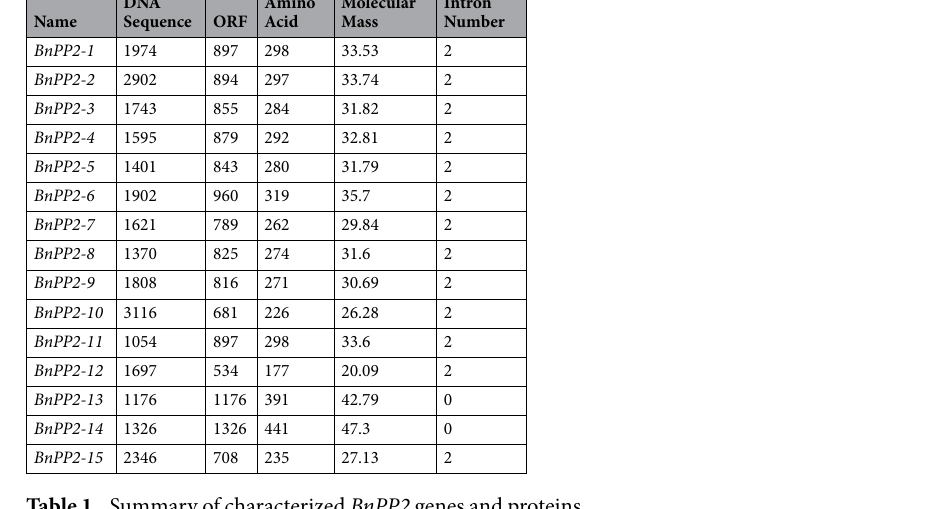
Table 1. Summary of characterized BnPP2 genes and